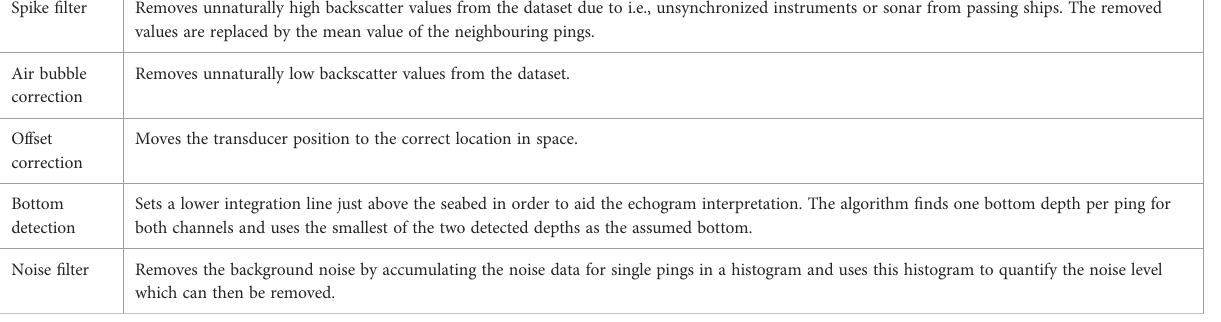
TABLE 1 Processing modules used in the processing software KORONA.